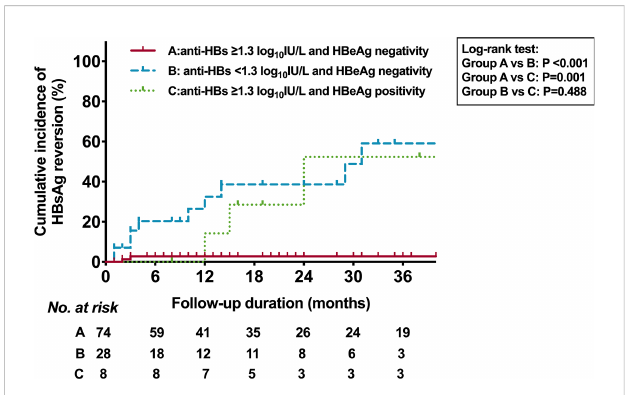
FIGURE 4 Kaplan-Meier estimates of cumulative incidence of HBsAg reversion based on HBeAg status and anti-HBs of 1.3 log10IU/L at EOT. HBsAg, hepatitis B surface antigen; HBeAg, hepatitis B e antigen; Anti-HBs, hepatitis B surface antibody; EOT, end of PEG-IFN treatment.